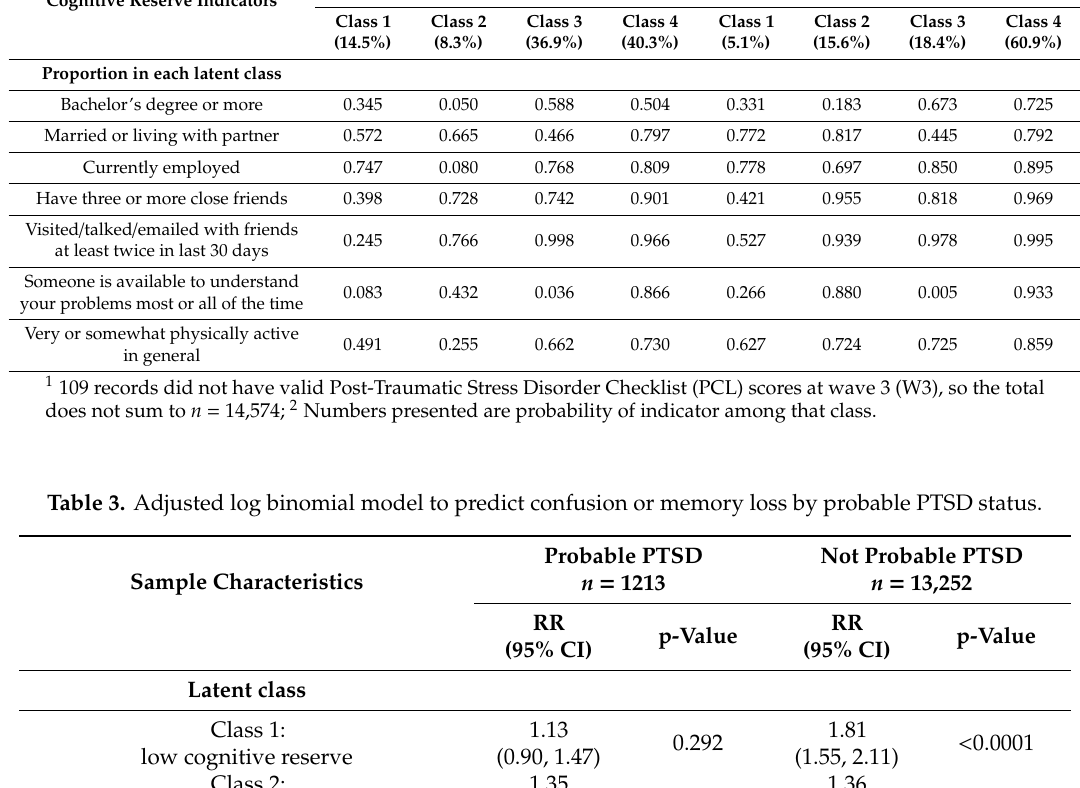
Table 2. Latent class membership by probable PTSD status based on cognitive reserve indicators. Cognitive Reserve Indicators